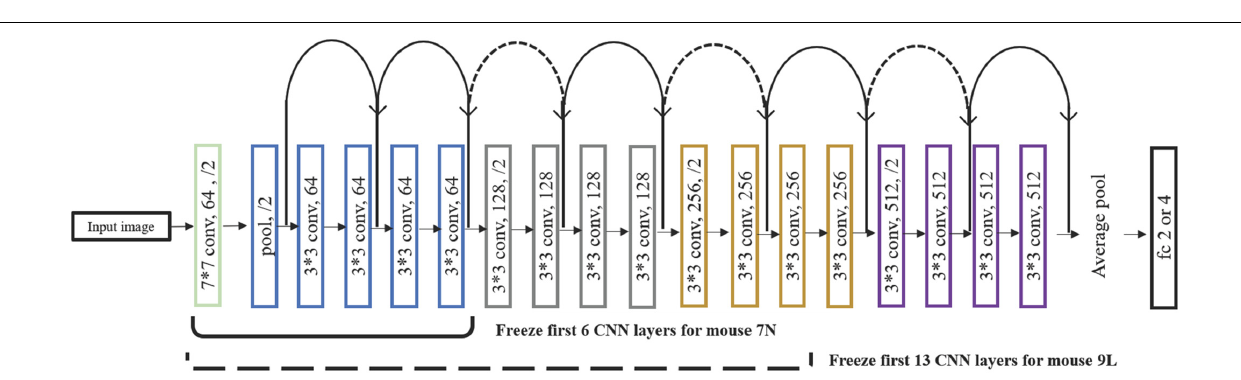
FIGURE 4 | The structure of the Resnet18 employed. Resnet18 was pretrained on the dataset ImageNet, which contains 1.2 million images with 1000 categories. The fully connected layer was changed to 2 to predict the outcome of the trial and to 3 and 4 to predict the maximum lever reaching position. We froze the initial values of the first several CNN (first 6 layers for mouse 7N and first 13 layers for mouse 9L) and trained the remaining CNN layers by using training set. Solid curves represent shortcut connections that performed identity mapping between feature maps that have the same dimensions. Dashed curves represent shortcut connections that performed identity mapping when feature maps have different